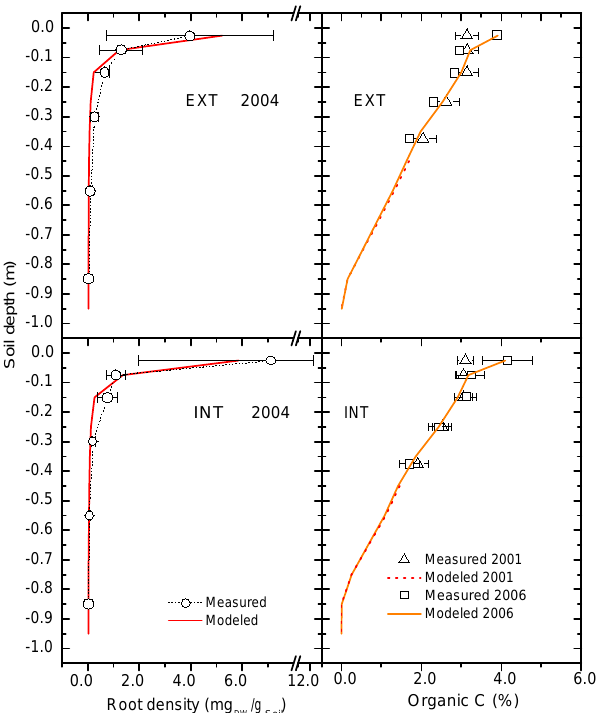
Fig. 4. Root density (left) and soil carbon concentration (right) for EXT (upper pane) and INT (lower pane). Measurements are given ±